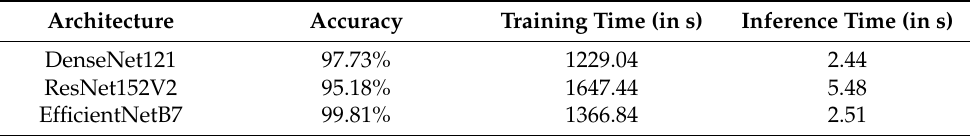
Table 6. Classification comparison on X-ray modality using different architectures in terms of accuracy and execution